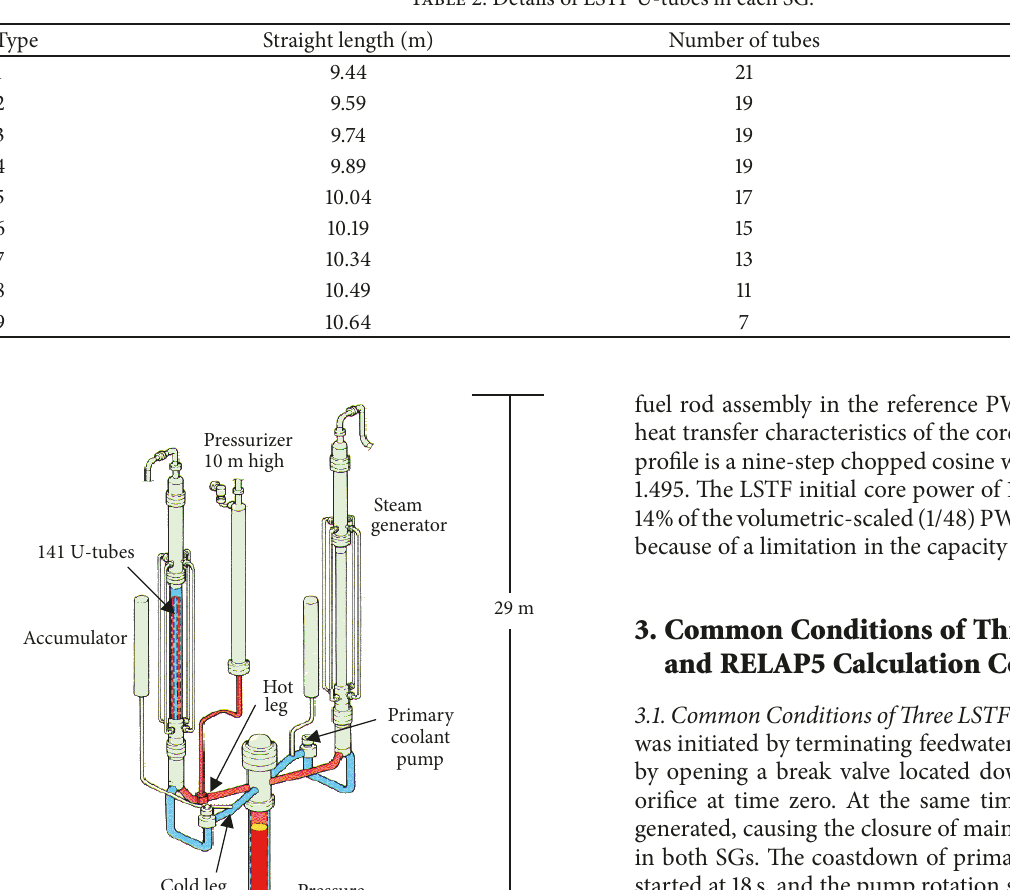
Table 2: Details of LSTF U-tubes in each SG.